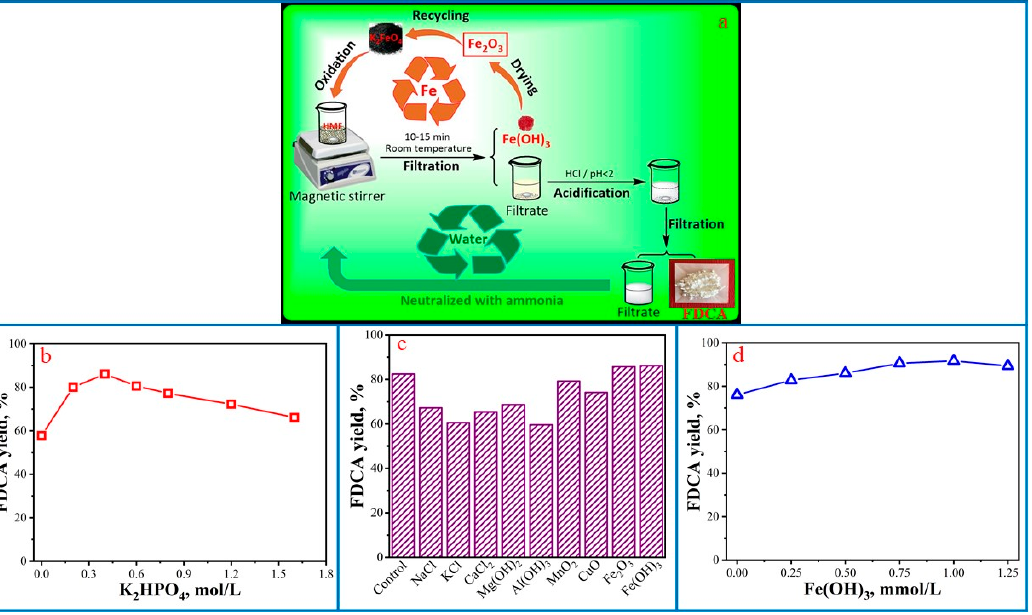
Figure 1. Oxidation sketch of HMF into 2,5-furandicarboxylic acid (FDCA) over K 2 FeO 4 , including the iron and water recycling ( a ), and effect of K 2 HPO 4 ( b ), metal compounds ( c ), Fe(OH) 3 ( d ) on the conversion of HMF to FDCA.